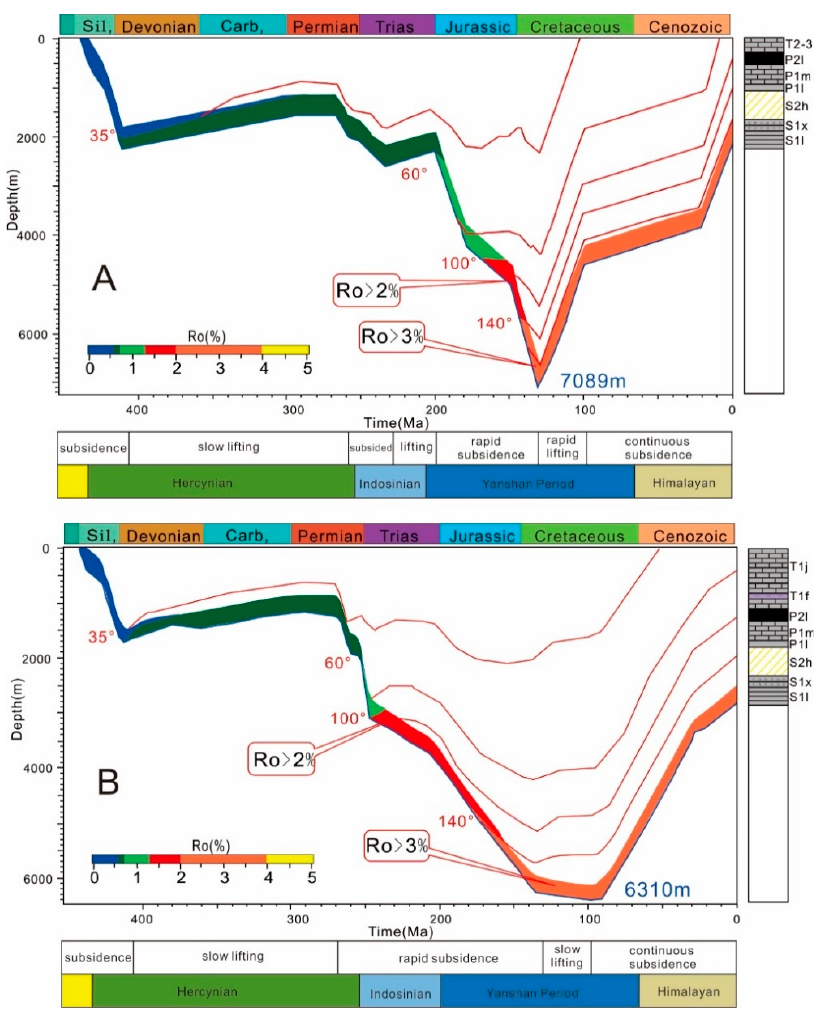
Figure 11. Buried curve of the Longmaxi Formation in southeast Chongqing. ( A ): well PY1, ( B ): well LY1.